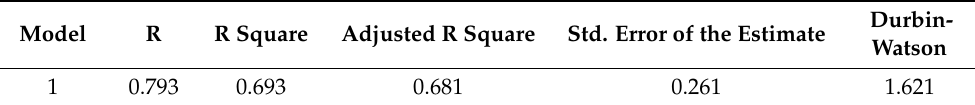
Table 10. Durbin–Watson